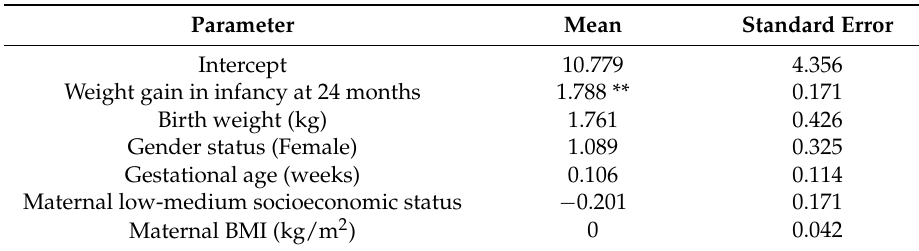
Table 2. Regression model of BMI at age 17 [8] (Ekelund analysis